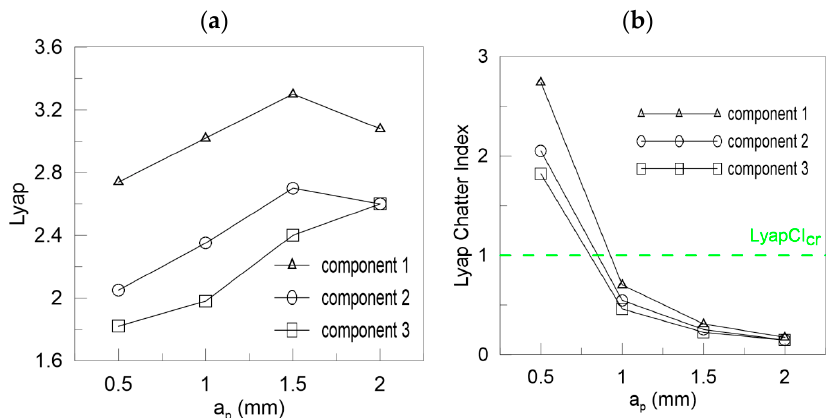
16 of 20 Figure 17. The TT chatter index (left axis) and the hypothetical stability lobe diagram (right axis) versus cutting velocity. In Figure 13 the Lyapunov chatter index ( L yap CI ) with proposed critical limit value ( L yap CI cr , green dashed line) is presented. The second component of the DHHT identified chatter the best, while the first one was the least accurate. The L max CI , shown in Figure 14, also indicates instability on the basis of the second component. The critical index L max CI cr equals about 7.5. Below the green dashed line cutting process is unstable. The L ent CI (Figure 15), the LCI (Figure 16) and the TTCI (Figure 17) had significantly smaller values in case of chatter than for stable milling. Thus, the proposed chatter indexes were precise and much better than typical RQA measures. Moreover, they were consistent with the hypothetical SLD presented by the blue line. In the case of cutting with different depths of cut, the ICIs are related to cutting depth a p as mentioned in Section 3.2. Then, the ICIs were much better than pure RQA. For instance, the Lyapunov exponent shown in Figure 18a increases with the cutting depth, but in the last case of a p = 2 mm, it decreases (the first and second component). Only the third component could be taken as a stability index. However, all the ICIs presented in Figures 18b, 19 and 20 diminish with the depth of cut, showing a transition from stable to unstable cutting. The L yap CI is much higher when the process